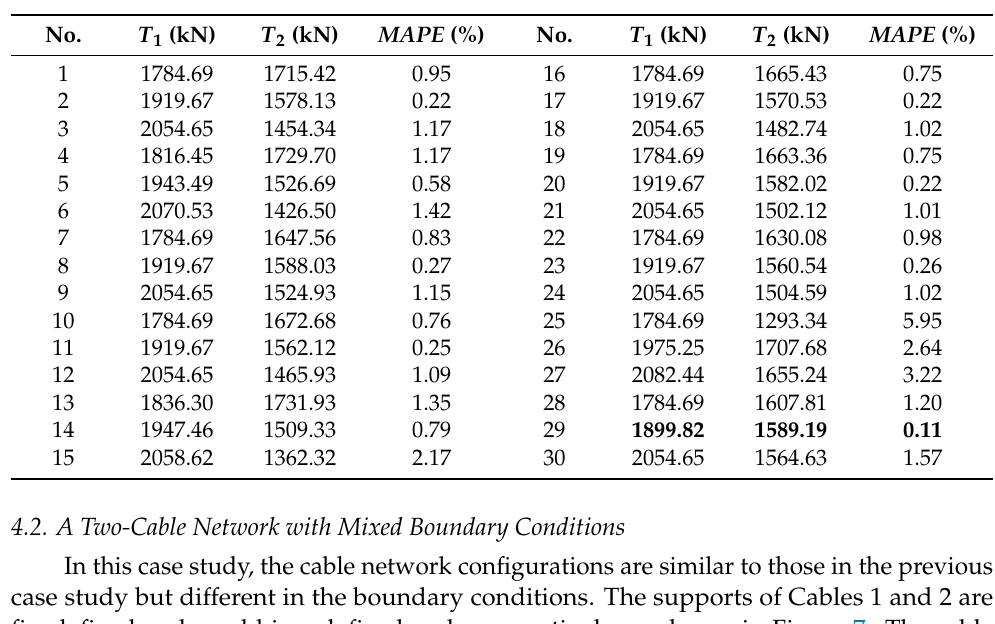
Table 5. MAPE of thirty satisfying combinations.